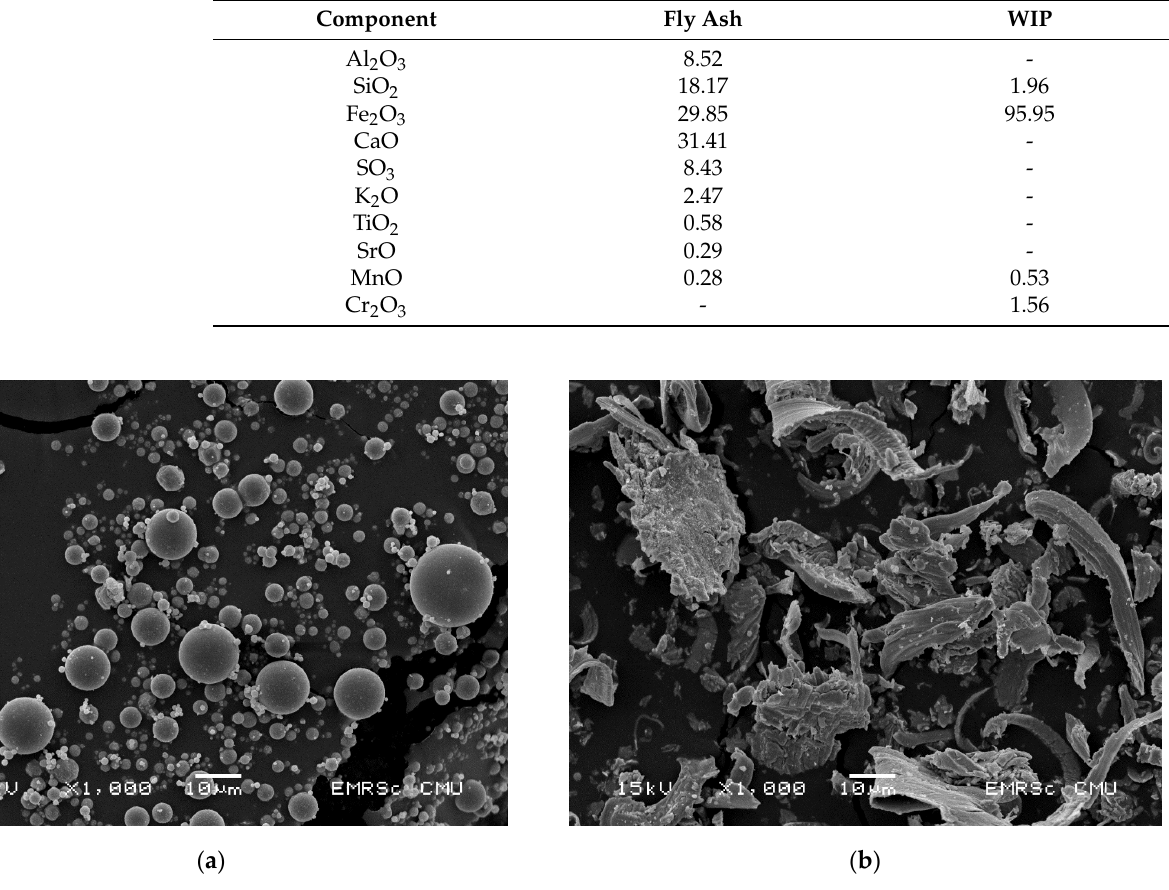
Table 1. Oxide compositions of Mae Moh fly ash and WIP.